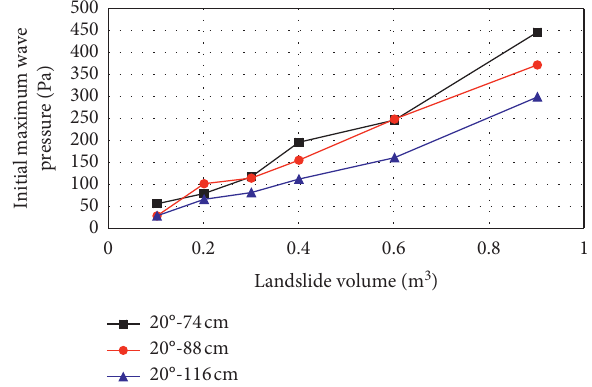
Figure 7: Stress diagram of landslide mass.